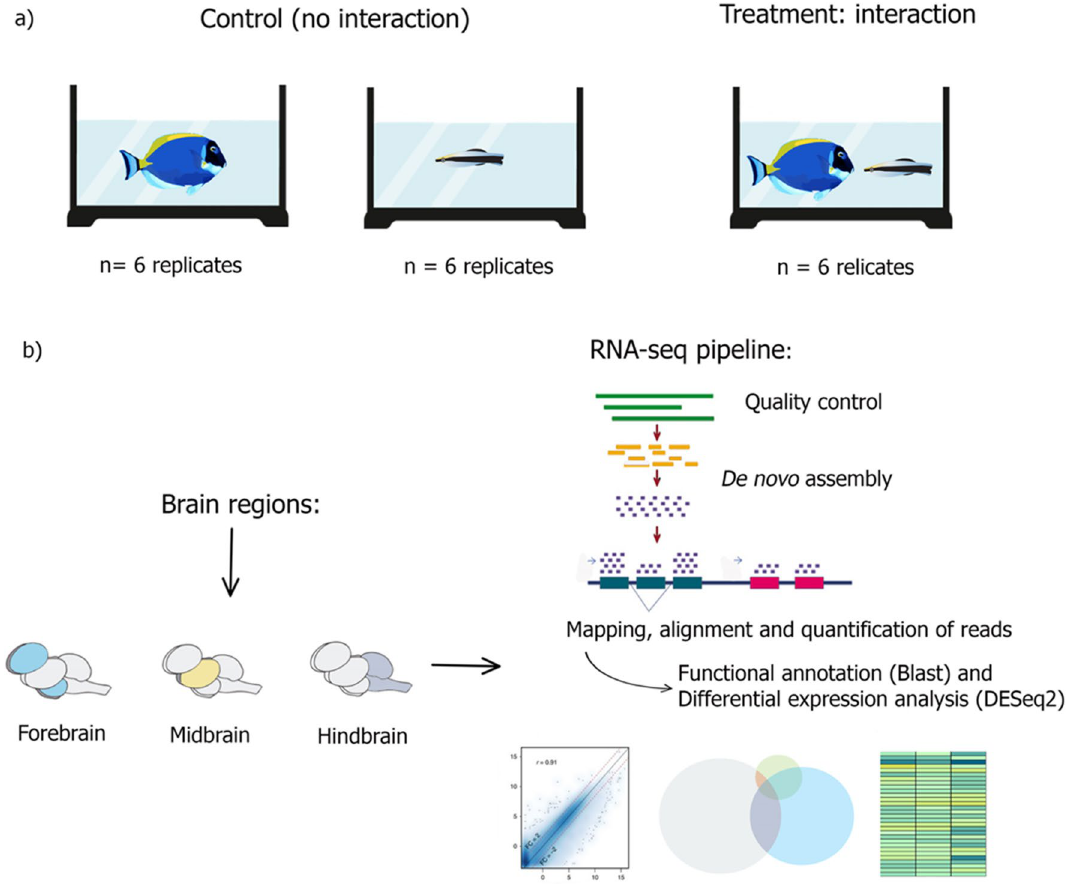
Figure 5. ( a ) Experimental design in which Labroides dimidiatus (N = 12) and Acanthurus leucosternon (N = 12) were kept separately (control: no interaction) or allowed to interact (condition: interaction) (DGAV—Permit 2018-05-23-010275). 40 min of videos were recorded. ( b ) Brain-regions dissections (Forebrain, Midbrain and Hindbrain) for each species, and RNA-seq pipeline including de novo transcriptome assembly, differential gene expression and functional analysis. Further details of the individuals used can be found at Supplementary Table